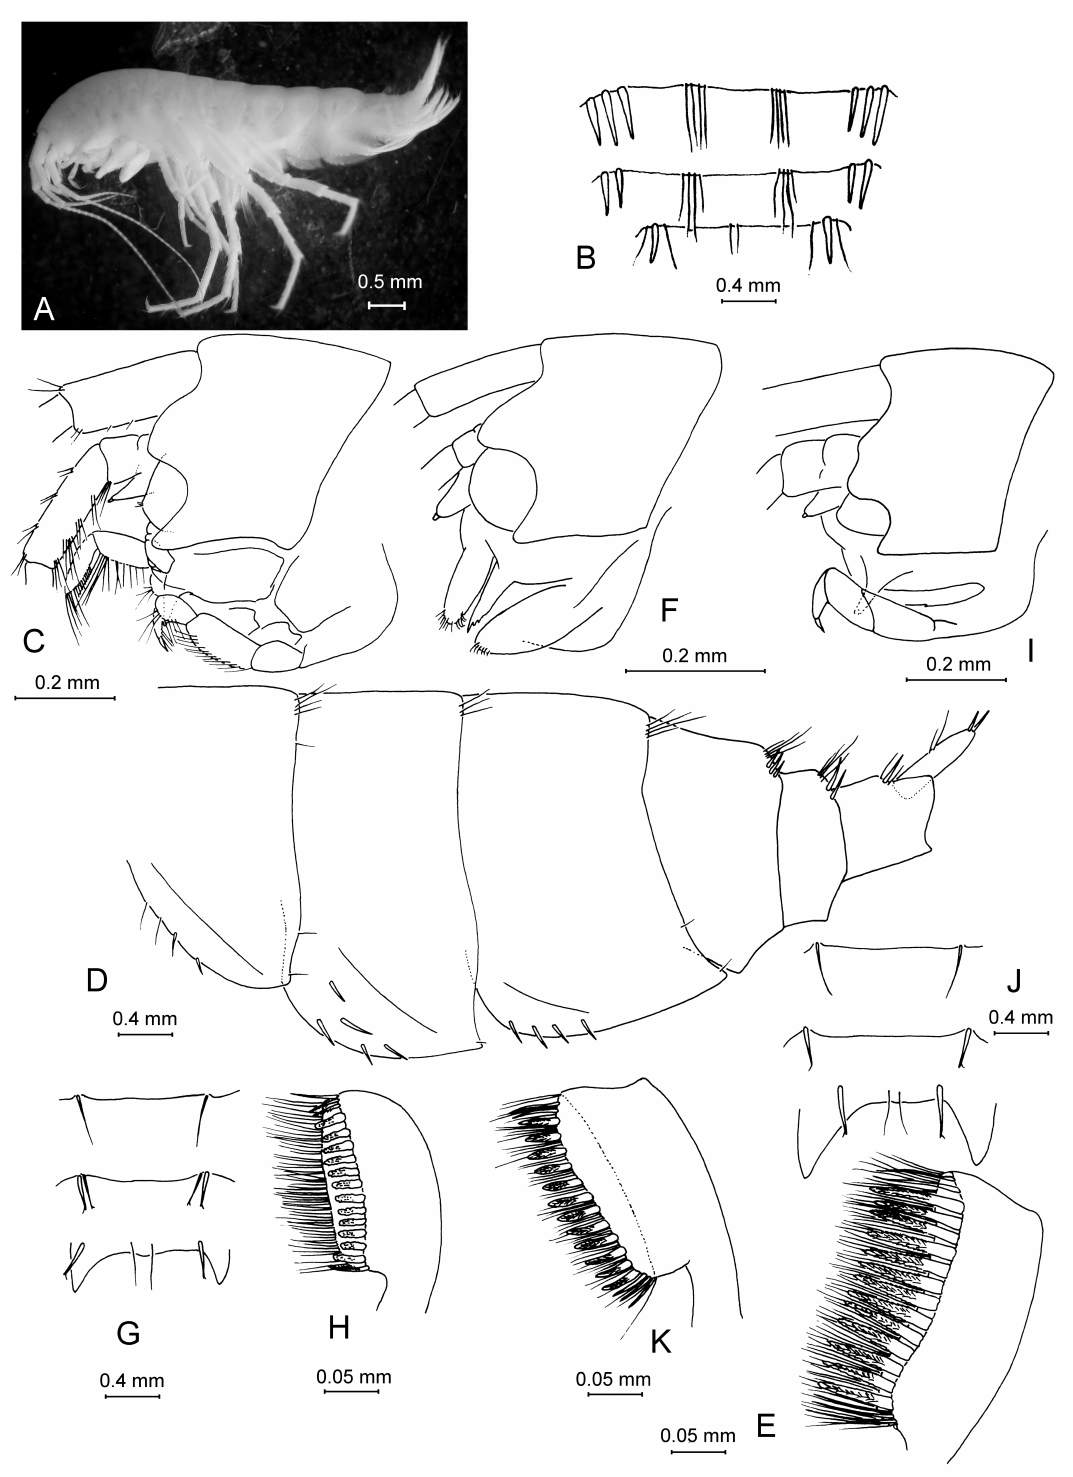
Fig. 4. — A–D . Anopogammarus birsteini Derzhavin, 1945. ♀, 9.0 mm, X44039/Cr-1645-FEFU: A . Habitus from left side. B . Urosome. C . Head. D . Metasomal and urosomal segments with telson. — E–G . Zenkevitchia sandroruffoi sp. nov. Paratype, ♀, 6.3 mm, X44045/Cr-1651-FEFU. E . Lateralia. F . Head. G . Urosome. — H–K . Adaugammarus pilosus sp. nov. Holotype, ♀, 13.5 mm, X44046/Cr- 1652-FEFU. H . Lateralia. I . Head. J . Urosome. K .